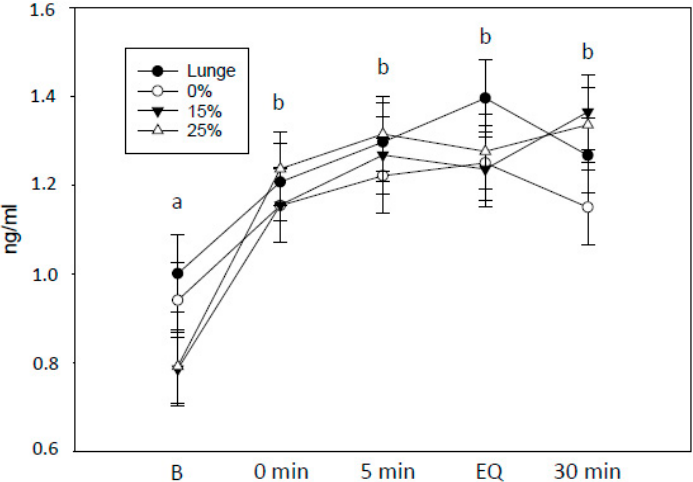
Figure 2. Salivary cortisol concentrations (ng / mL) from the 20 horses (mean ± se) in each treatment, incl. the baseline lunge test. The amount of exercise (warm-up and test) was the same in all treatments. 0% (control): The rider rode without additional weight; 15% and 25%: The rider rode with additional 15% or 25% of her bodyweight, respectively, in a balanced order across three test days. Five saliva samples were collected from each horse per day: B: Baseline, 0 min: Just after the lunge / dressage test, 5 min: 5 min after the lunge / dressage test, EQ: Just after the saddle pressure / gait symmetry test, 30 min: 30 min after the lunge / dressage test. Due to technical issues with the equipment, the duration of the gait symmetry test varied and the EQ and 30 min samples are less informative. Di ff erent letters indicate a significant e ff ect of sampling time.